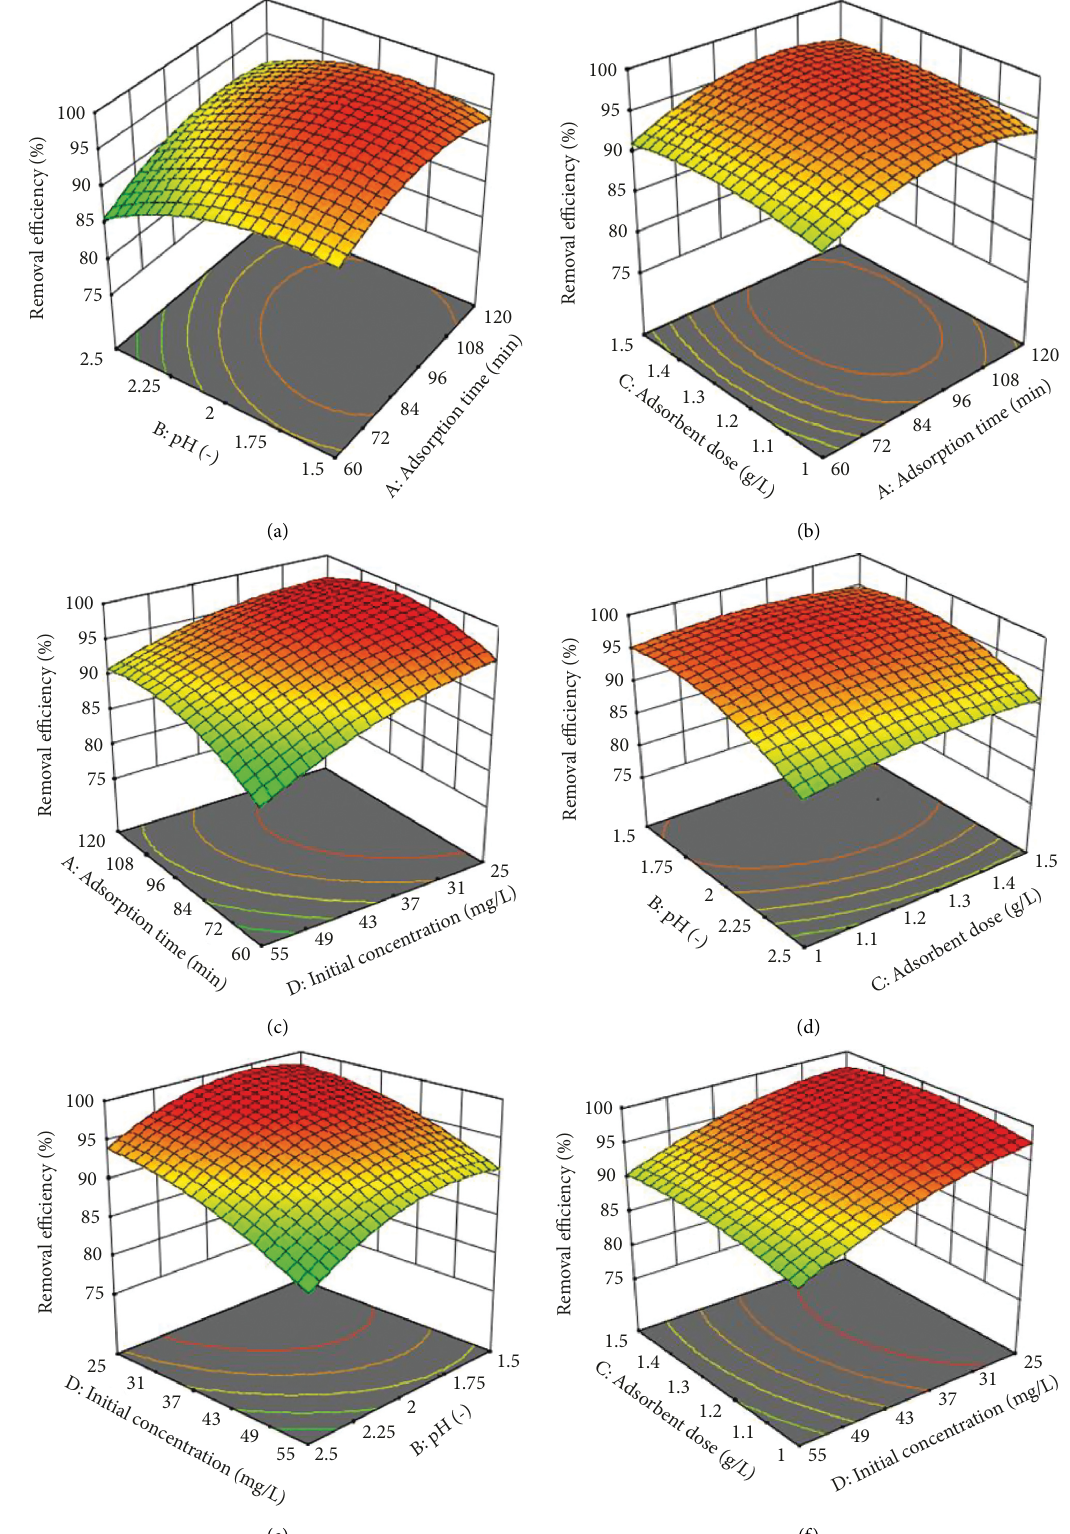
Figure 11: Interaction effect of (a) adsorption time vs. pH (adsorbent dose: 1.25g/L, initial concentration: 40 mg/L), (b) adsorption time vs. adsorbent dose (pH: 2, initial concentration: 40mg/L), (c) initial concentration vs. adsorption time (adsorbent dose:1.25 g/L, pH: 2), (d) pH vs. adsorbent dose (adsorption time:90min, initial concentration: 40mg/L), (e) pH vs. initial concentration (adsorption time:90